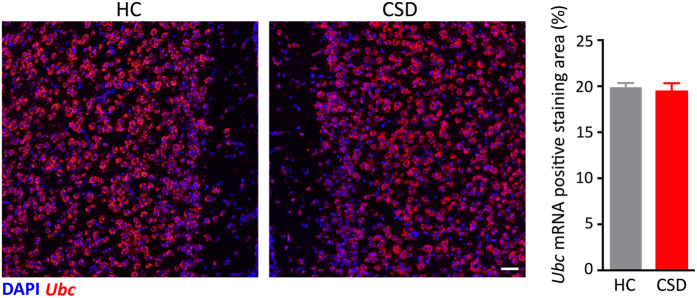
Stress does not alter the expression of ubiquitin C (Ubc) mRNA.(A) Representative fluorescent micrographs of Ubc expression show similarity between HC and CSD medial prefrontal cortex. Area of positive Ubc labeling was analyzed within this region and the graph to the right of the micrographs summarize the results. Results are expressed as mean ± SEM (n = 5 per group) Scale bar = 50 μm.